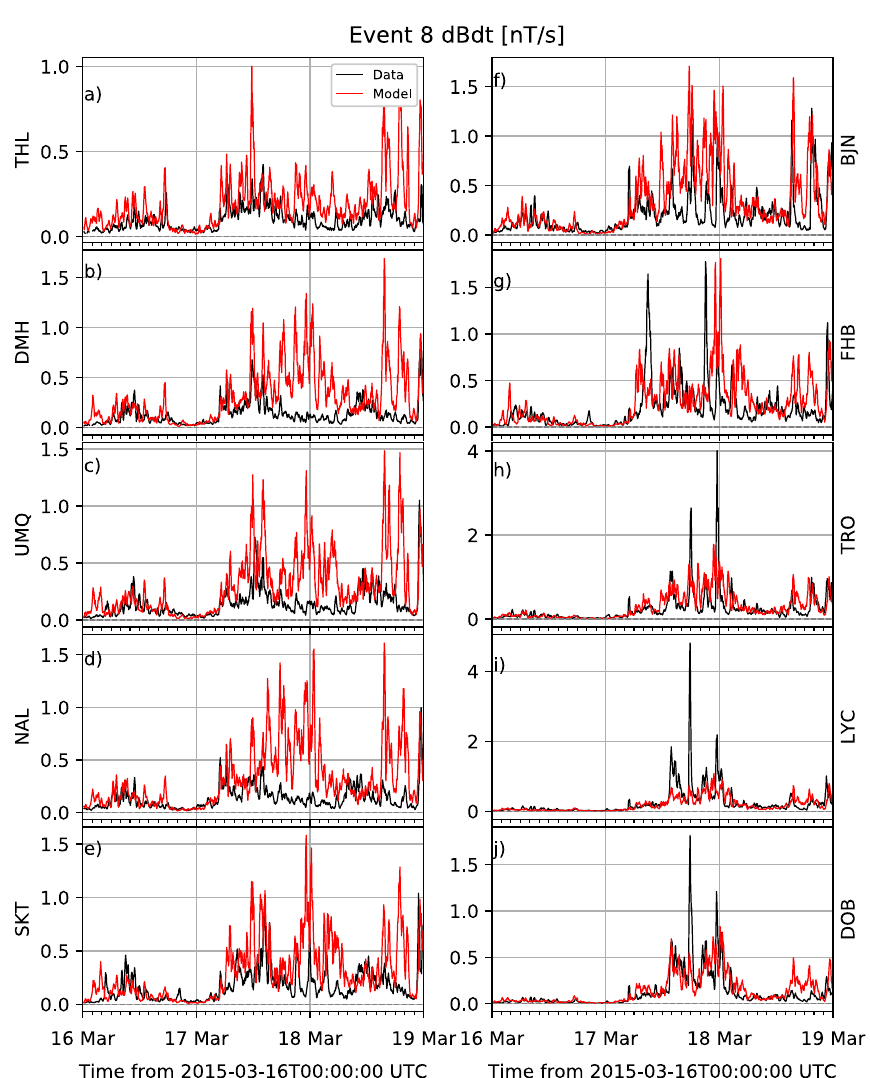
Fig. 10. Ground magnetic d B /d t at all ground magnetometer stations for event 8. The black line shows the observed perturbations and the red line shows the modelled ground perturbations. For this fi gure both observation and model are smoothed using a moving average window of 20